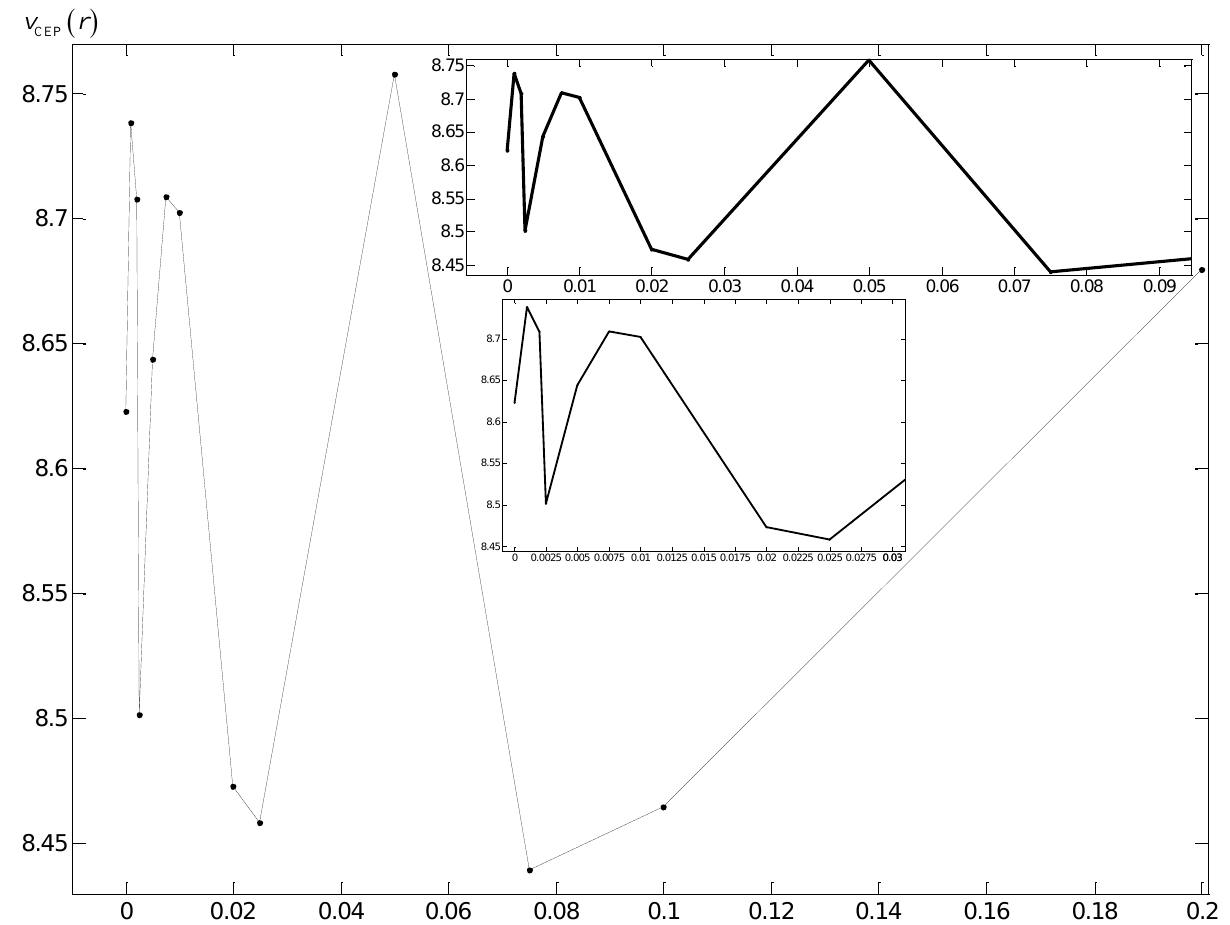
Fig. 3. Re-evaluation of the function   v r on 100 trained 4800-240-26-P by parameters (20) for the first and second sets in (26); the third set in (26) is CEP evaluated on 130 trained